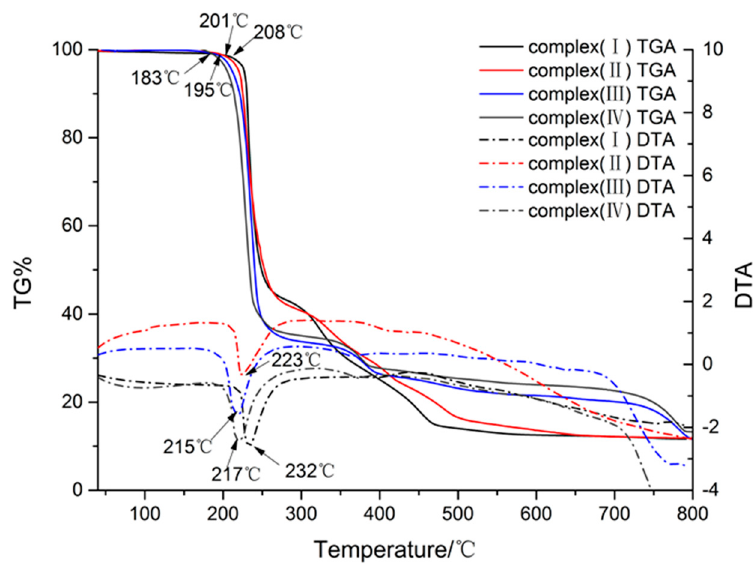
Figure 7. Thermogravimetric analysis (TGA) and differential thermal analysis (DTA) curves for (I), (II), (III), and (IV).